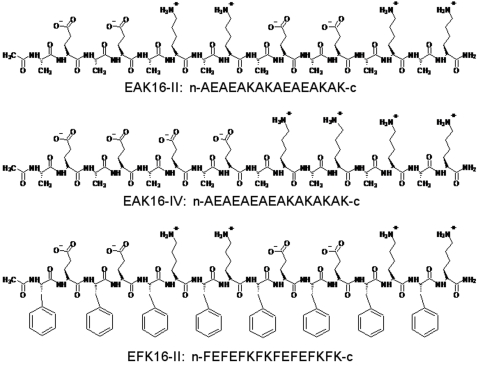
Molecular structures and sequences of EAK16-II, EAK16-IV and EFK16-II.N and C termini are protected by acetylation and amidation, respectively.